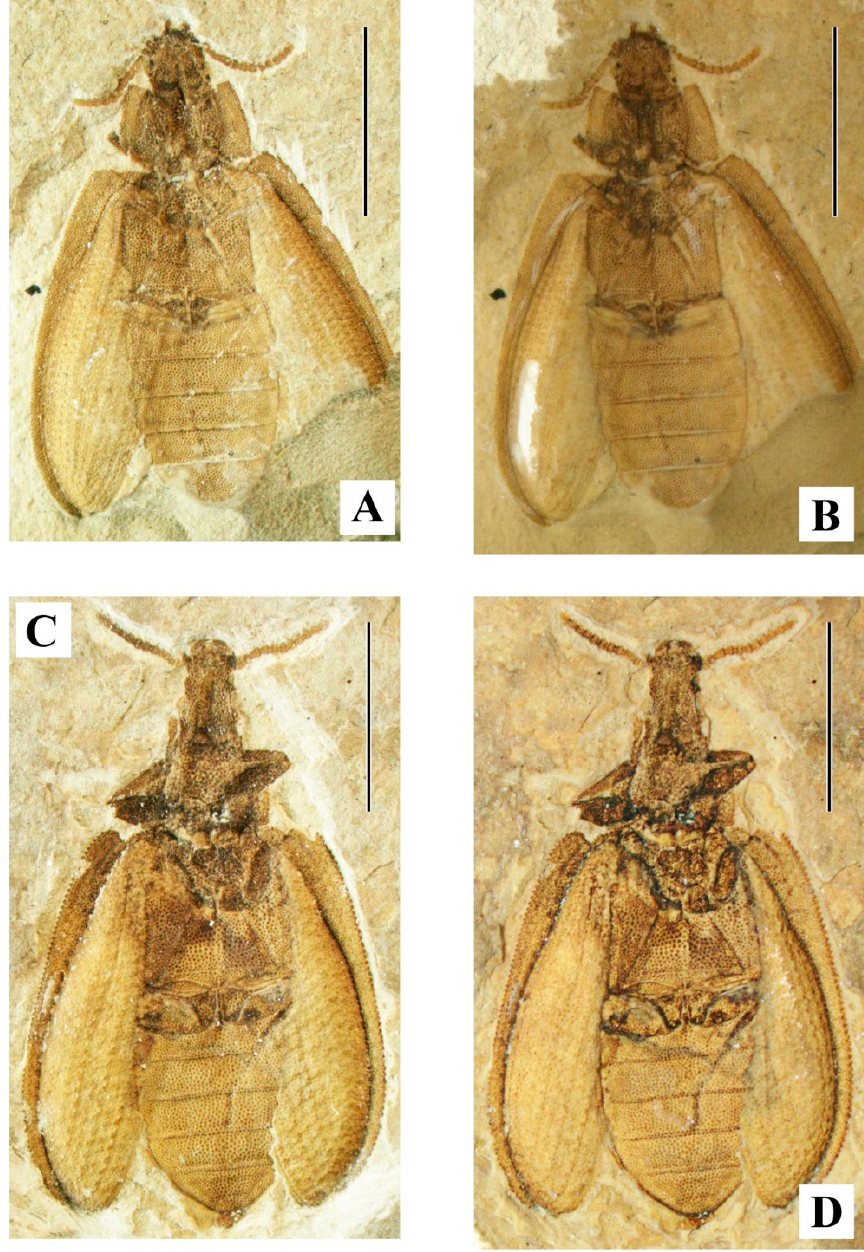
Figure 12. Ommatinae (Cupedidae): A – B — Odontomma sulcatum comb. nov. [ Brochocoleus ], holotype CNU –C-LB2006011-1, part (Lower Cretaceous, Lower Aptian Liaoning, Chaomidian): A —dry and B —wettened by alcohol; length of print 13.5 mm, scale bar = 2.9 mm; original. C – E — Odontomma trachylema , holotype, part CNU –C-LB2005009-1 (Lower Cretaceous, Lower Aptian Liaoning, Chaomidian): C —dry, D –part wettened by alcohol; length of print 19.0 mm, scale bar = 6.3 mm;